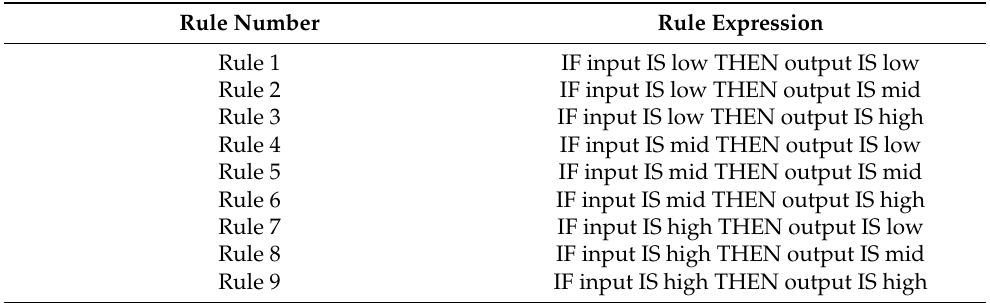
Table 2. Set of fuzzy rules from which a optimization method find three rules for implementation in